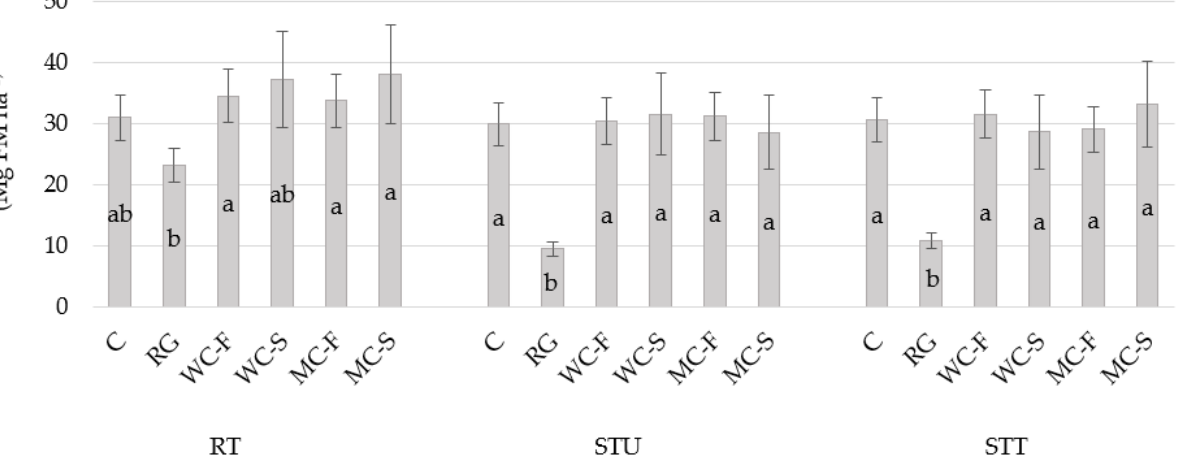
Figure 4. Influence of living mulches on cabbage total head fresh matter yield on both locations. Values with at least one identical letter indicate non-significant differences among LM treatments at α = 0.05. C = control, RG = perennial ryegrass, WC-F = white clover — fall seeded, WC-S = white clover — spring seeded, MC-F = micro clover — fall seeded, MC-S = micro clover — spring seeded; RT = rototilling, STU = strip till + untreated, STT = strip till + treated.